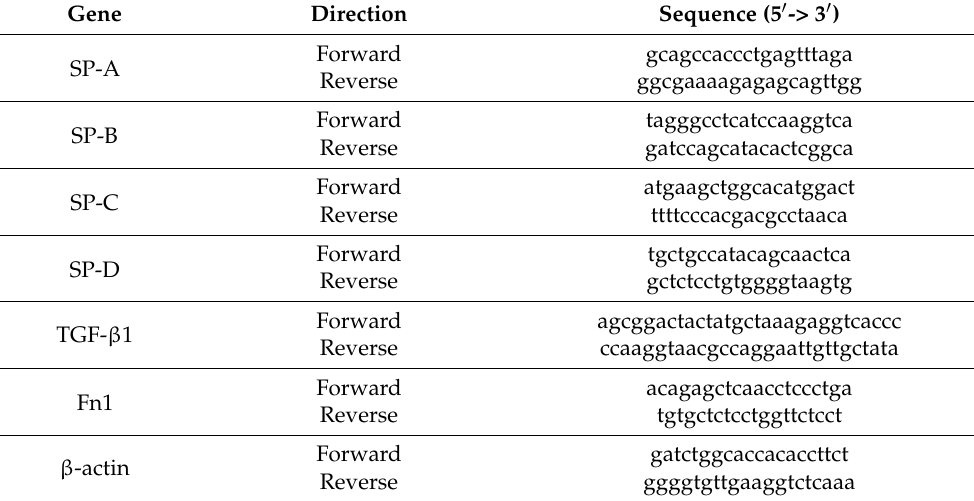
Table 1. Oligonucleotides used in real-time